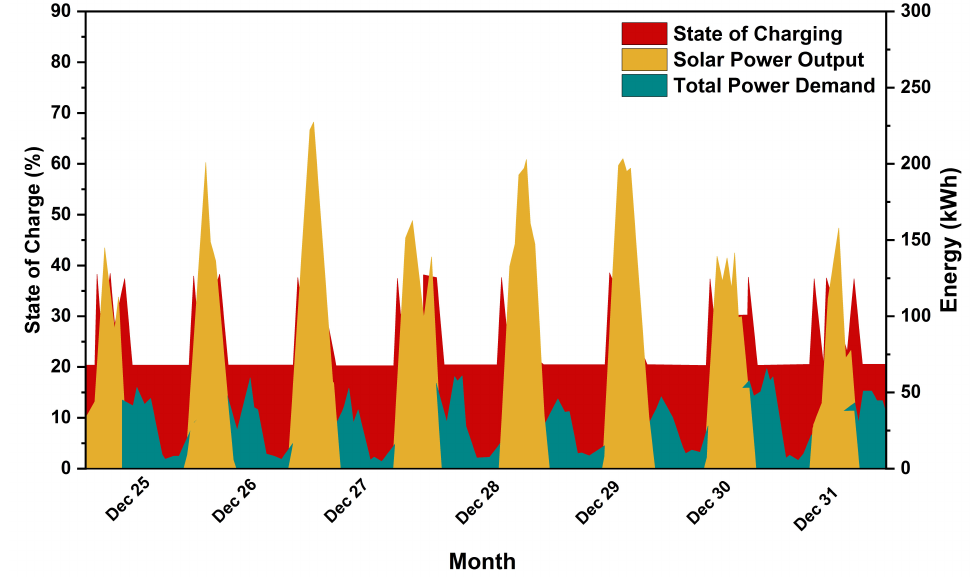
Figure 9. Battery SOC and energy balance of hybrid microgrid system for the third week of